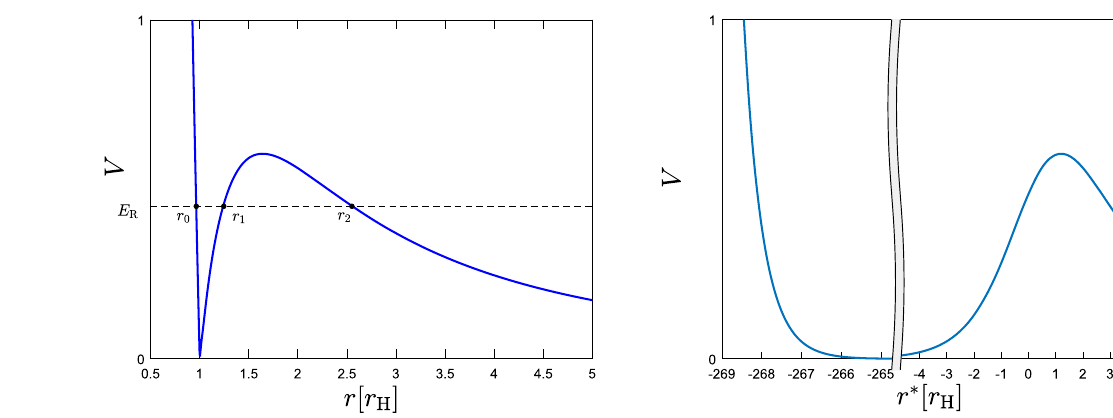
Fig. 3 The scattering potential (28) of axial perturbations for α equal the generalized Bohr–Sommerfeld rule (30) is satisfied. On the right to the Compton wavelength of a cosmological black hole with M • = panel we plot the potential with respect to the tortoise coordinate r ∗ 10M (cid:2) , that corresponds to ε = 3 . 8 · 10 − 78 . We used in these plots the (29). It is r ∗ ( r = r H − α/ 2 ) = − 180 . 3 r H , r ∗ ( r = r H ) = − 179 . 4 r H , ( ± ) = 8. The radii r r ∗ ( r = r H + α/ 2 ) = − 177 . 9 r H solution K = 1, N = 3 with A 0 , r 1 , r 2 are specified 3 by the condition E R = V and E R is defined for each mode n such that